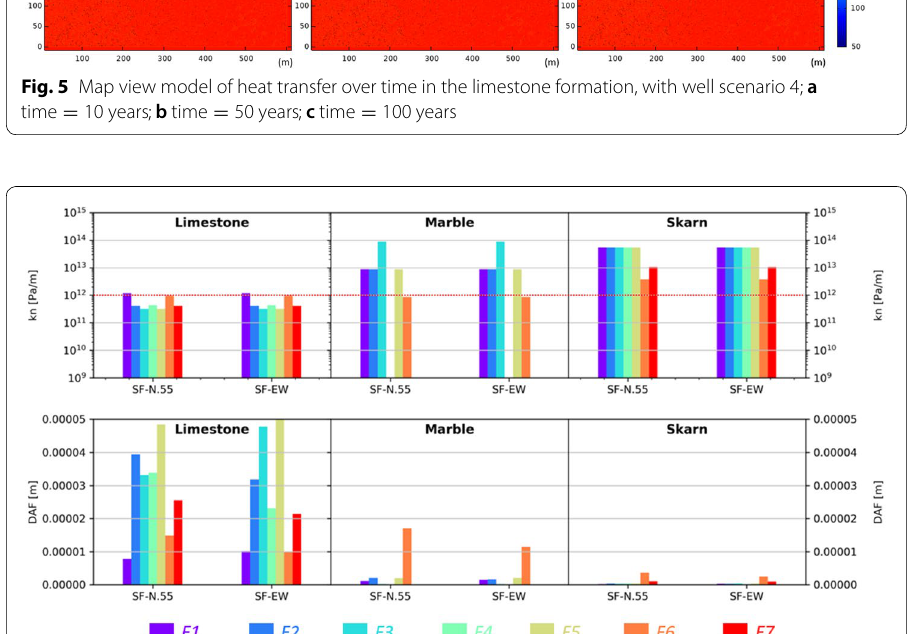
Fig. 6 The spring constant, and how mechanical properties influence fracture deformation (DAF) under